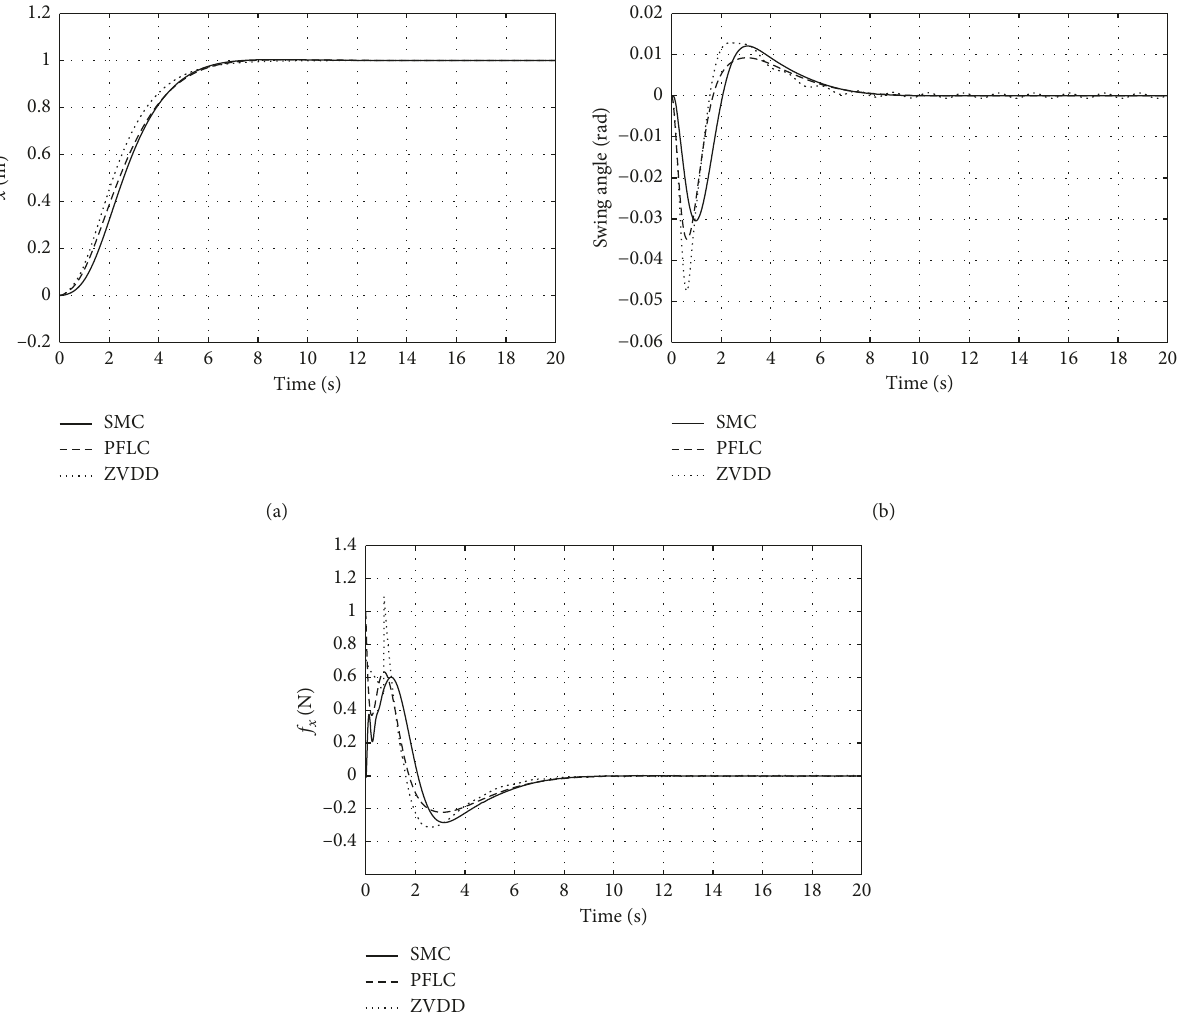
x , comparison of the proposed SMC with PFLC and